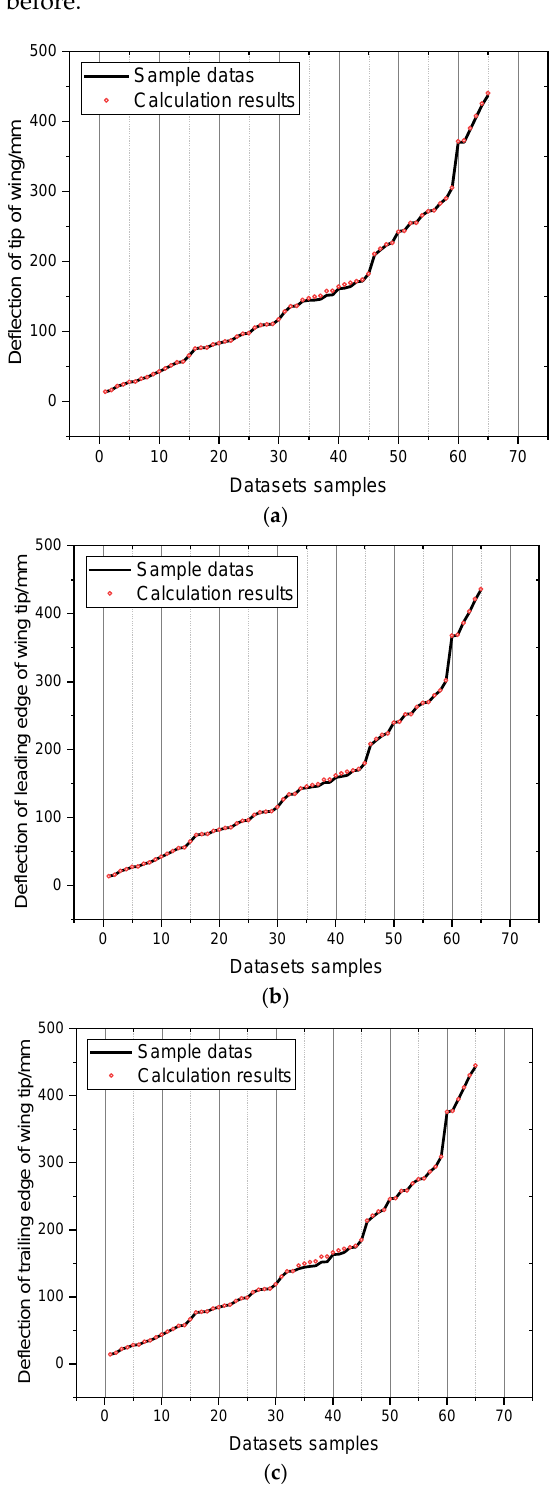
Figure 8. Prediction of wing tip deflection of wing tip point, leading edge point and trailing edge point. ( a ) point of the wing tip on the beam. ( b ) leading edge point of the wing tip. ( c ) trailing edge point of the wing tip.